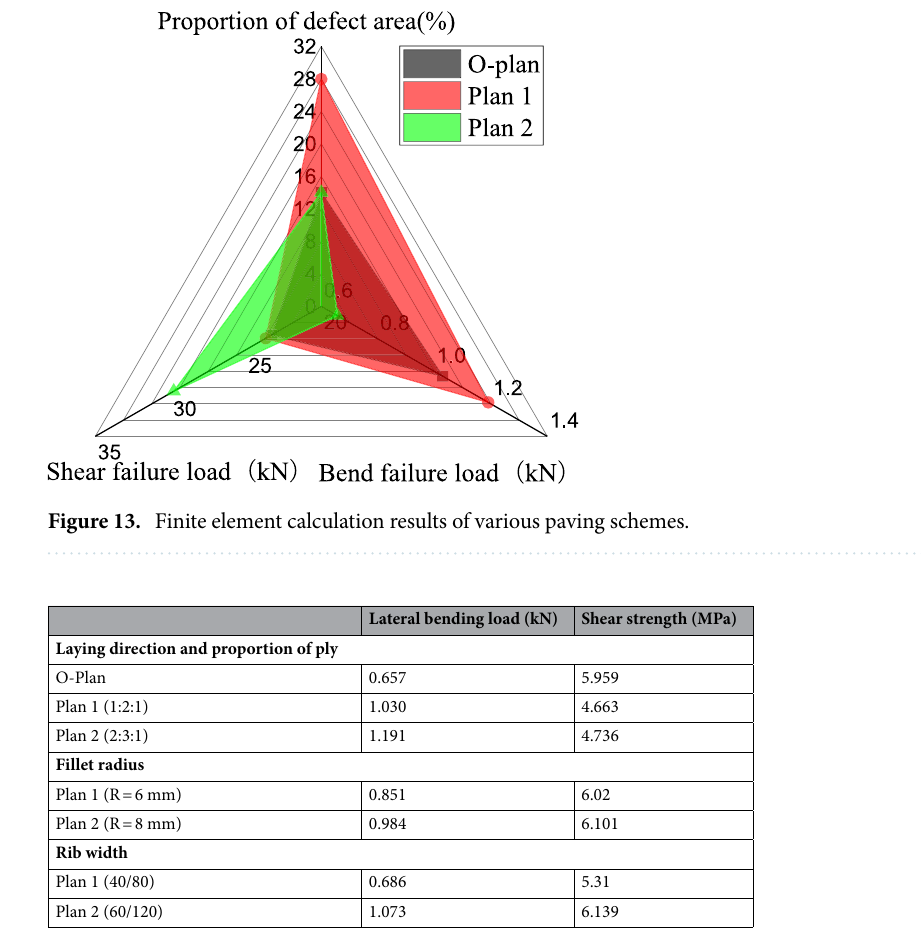
Table 8. Research on the influence law of design parameters about defective specimen.